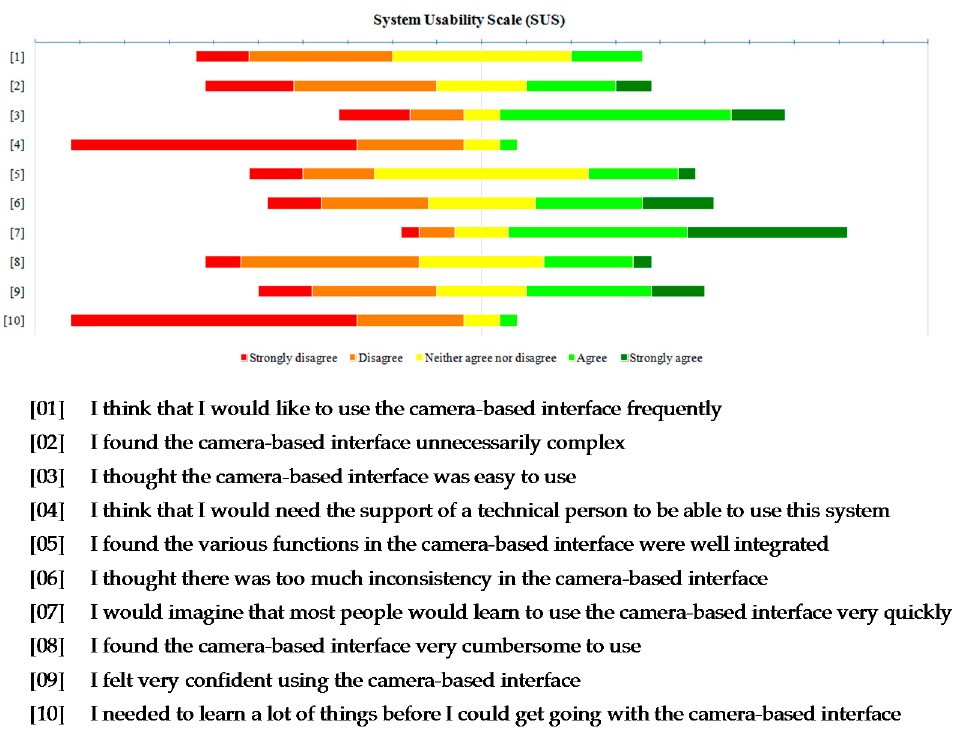
Figure 14. SUS questionnaire.